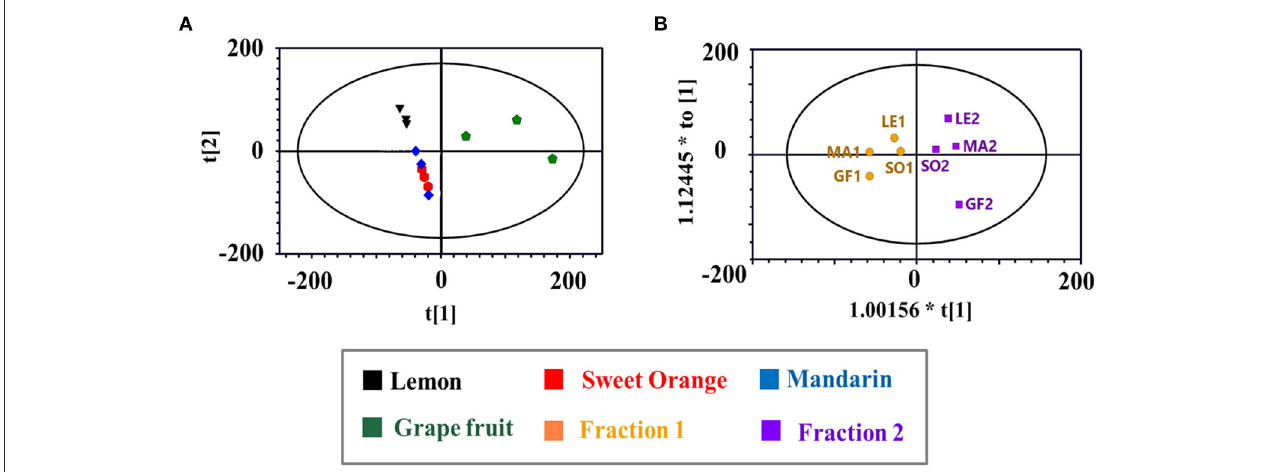
FIGURE 3 | (A) The principal component analysis (PCA) scores plot of citrus EOs samples; (B) The orthogonal partial least squares discriminant analysis (OPLS-DA) scores plot of the two fractions of citrus EOs samples. Each point represented an individual EOs sample. Compositions were labeled in the loading